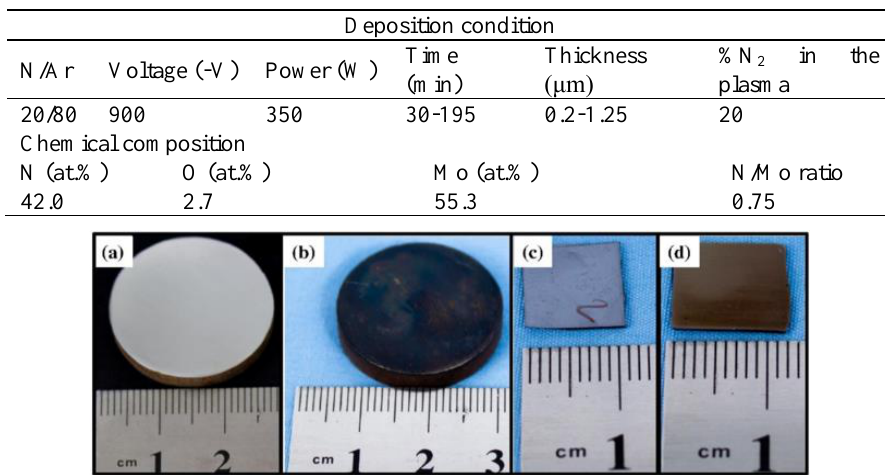
Table 1. Main parameters and chemical composition of molybdenum nitride film